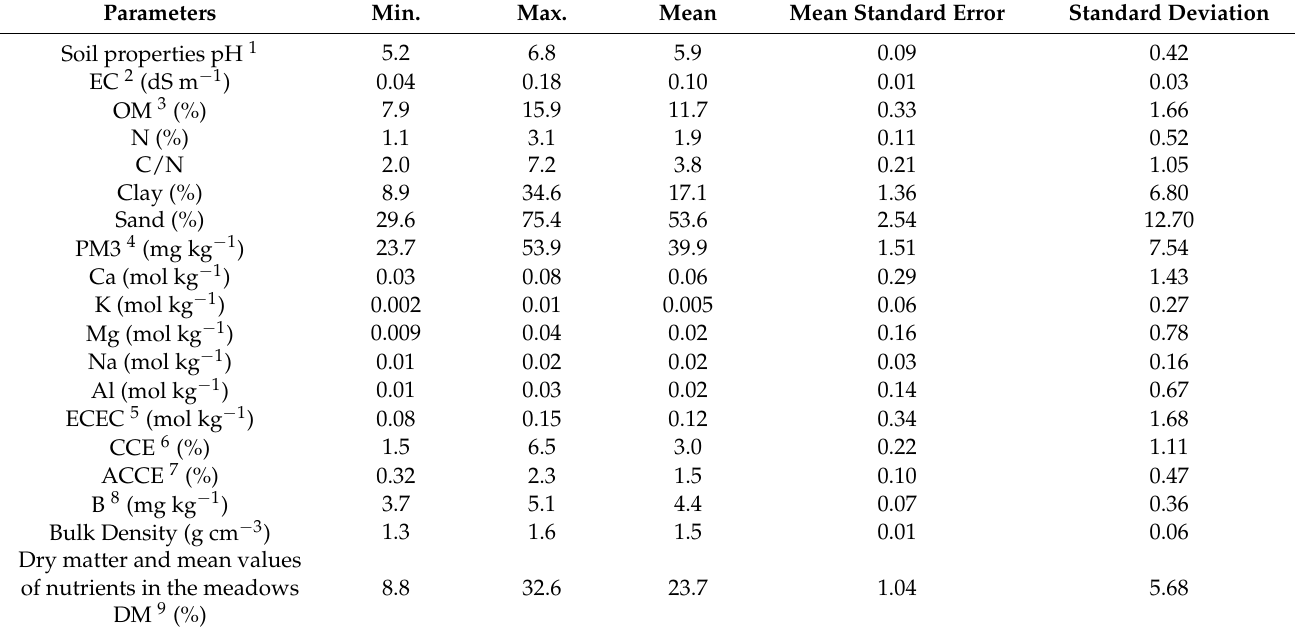
Table 2. Descriptive statistics for the soil general properties and mean values of dry biomass and nutrients concentrations in the